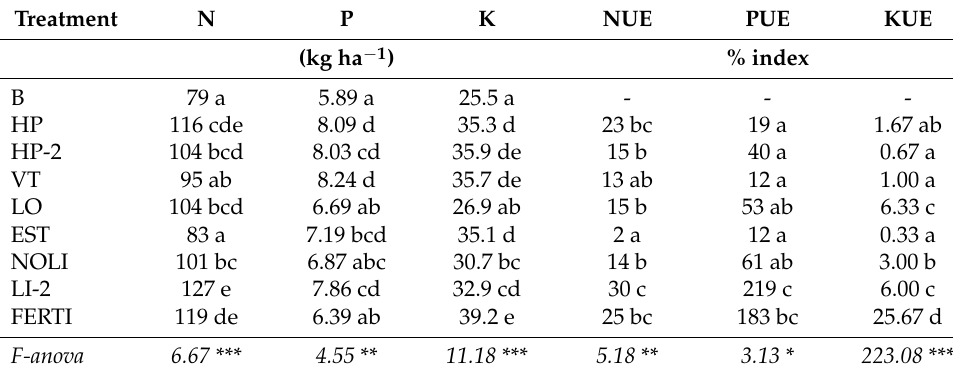
Table 6. N, P, K extraction by dill, according to